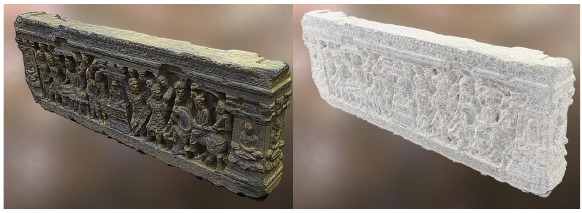
Figure 2/2.1: Photogrammetry documentation of Gandh ā ra- style carved grey schist Shakyamuni, Bodhisattva (gilt), Standing Maitreya and narrative relief.